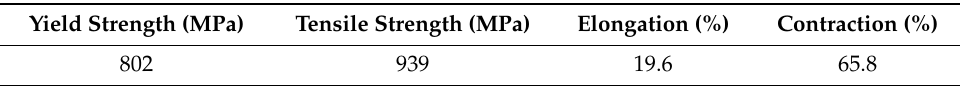
Table 2. Mechanical properties of steel 31CrMoV9.